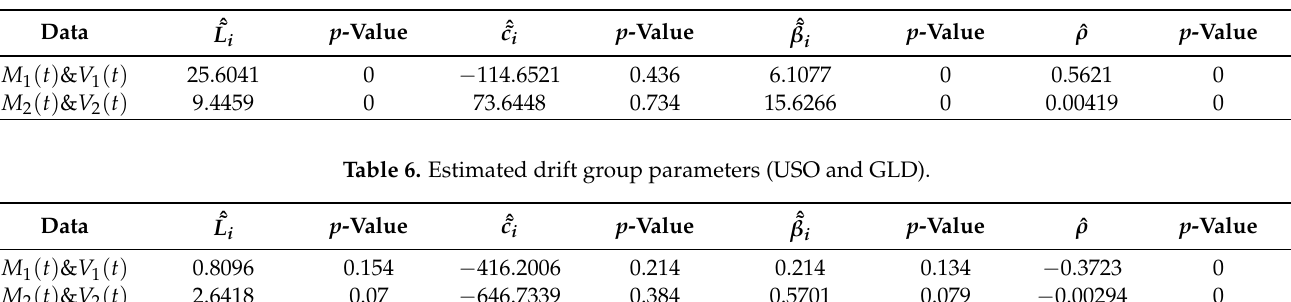
Table 5. Estimated drift group parameters (VIX and VSTOXX).